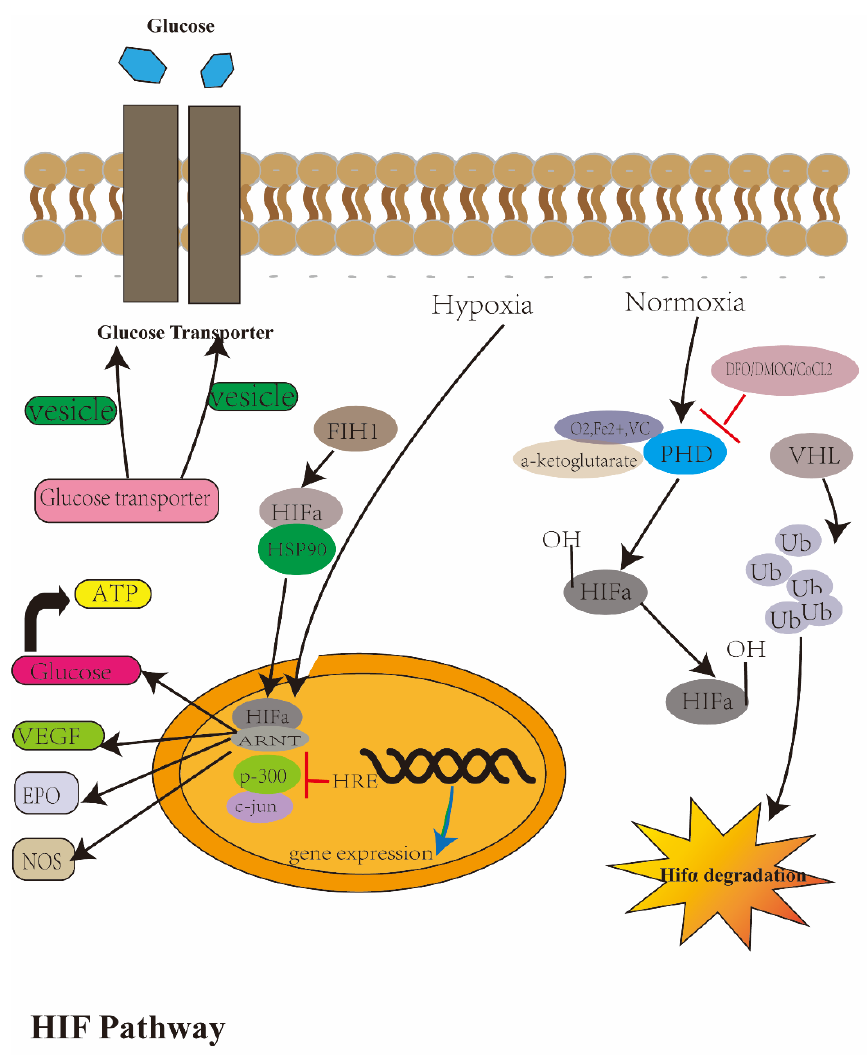
Figure 1. The introduction of the hypoxia